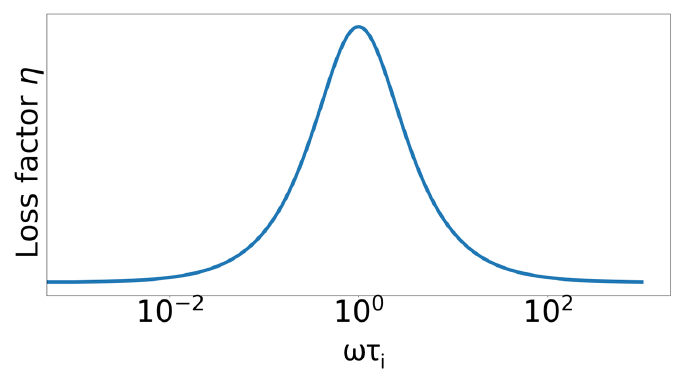
Figure 1. Dependency of the loss factor on the excitation cycle frequency ω